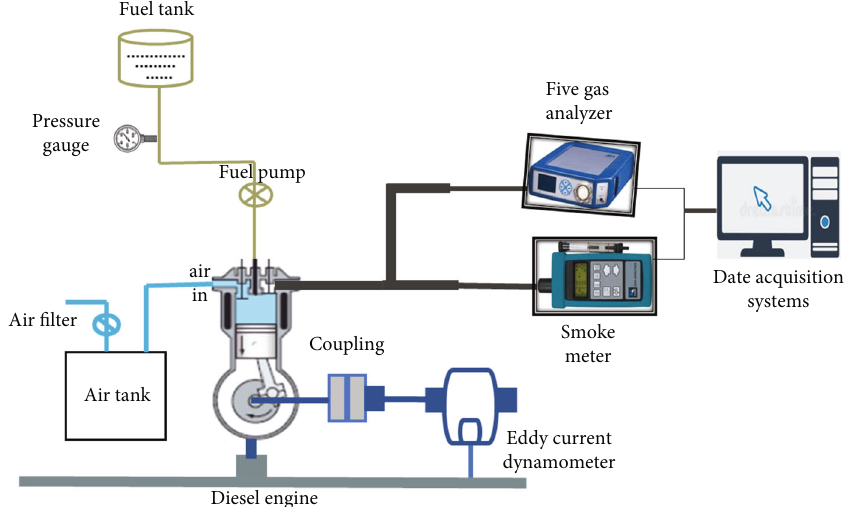
Figure 4: Experimental